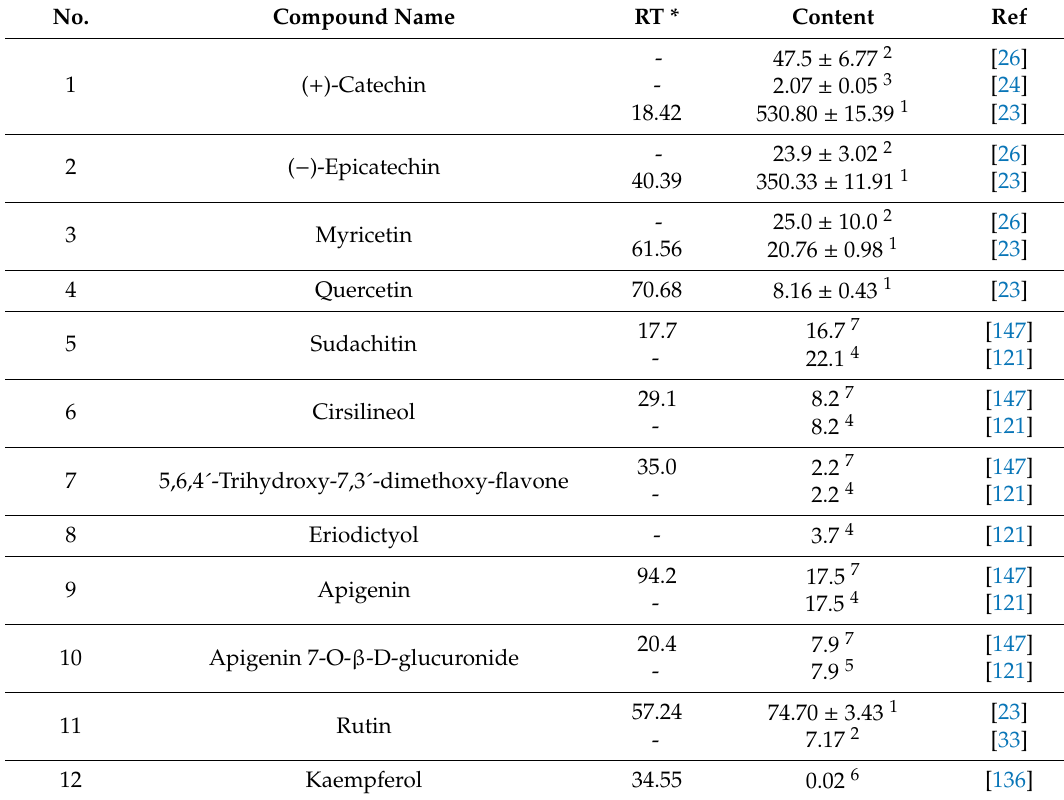
Table 5. The retention time and content of di ff erent identified flavonoids, flavanols, and flavonol glycosides in the green walnut husk.